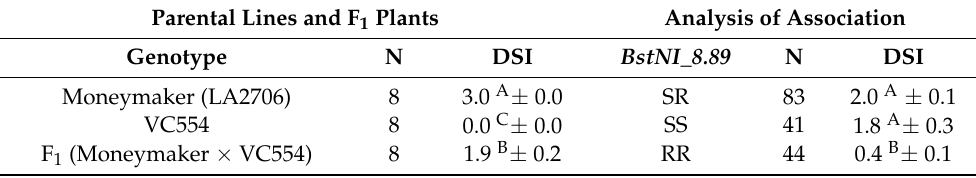
Table 7. Analysis of association between the BstNI_8.89 marker and ToBRFV disease severity index (DSI) in F 2 plants originating from an initial cross between the susceptible genotype LA2706 and the resistant VC554